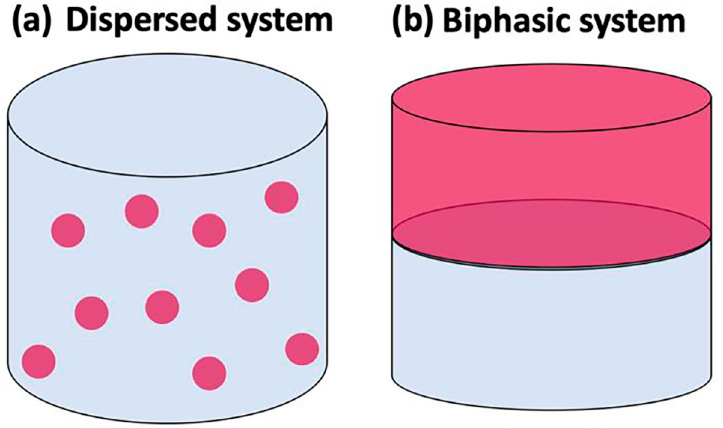
Figure 1. Schematic of the two extreme mixing cases of fluid–fluid systems. ( a ) Dispersed system; ( b ) Biphasic system. Reprinted from [18].